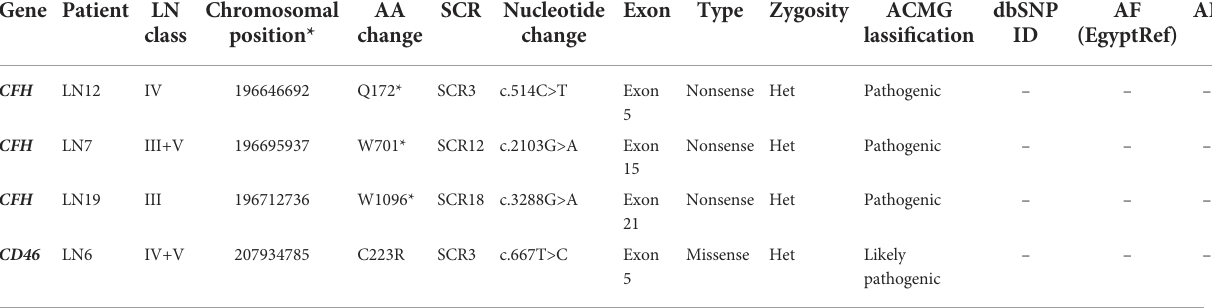
TABLE 5 Pathogenic or likely pathogenic